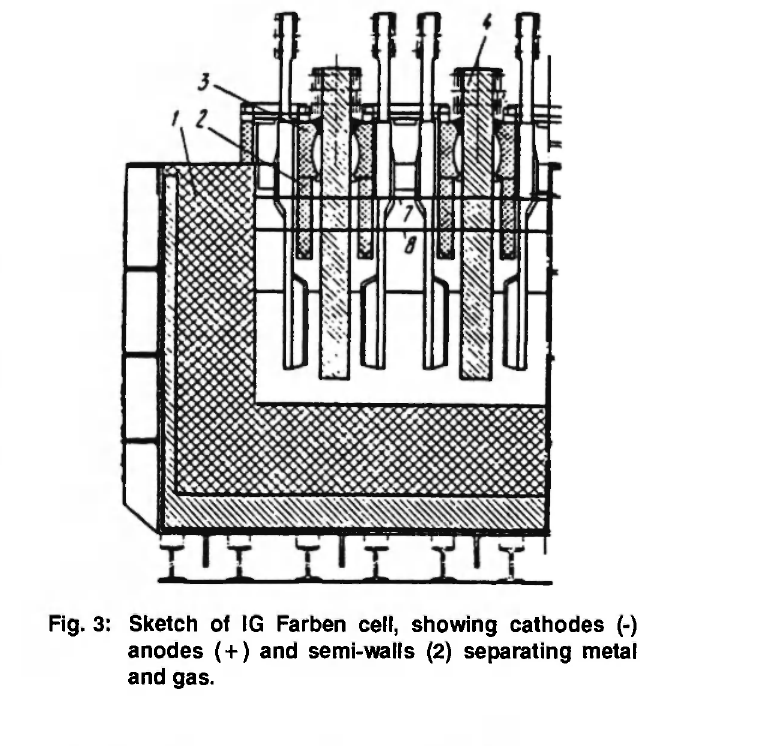
Fig. 3: Sketch of IG Farben cell, showing cathodes (-) anodes ( + ) and semi-walls (2) separating metal and